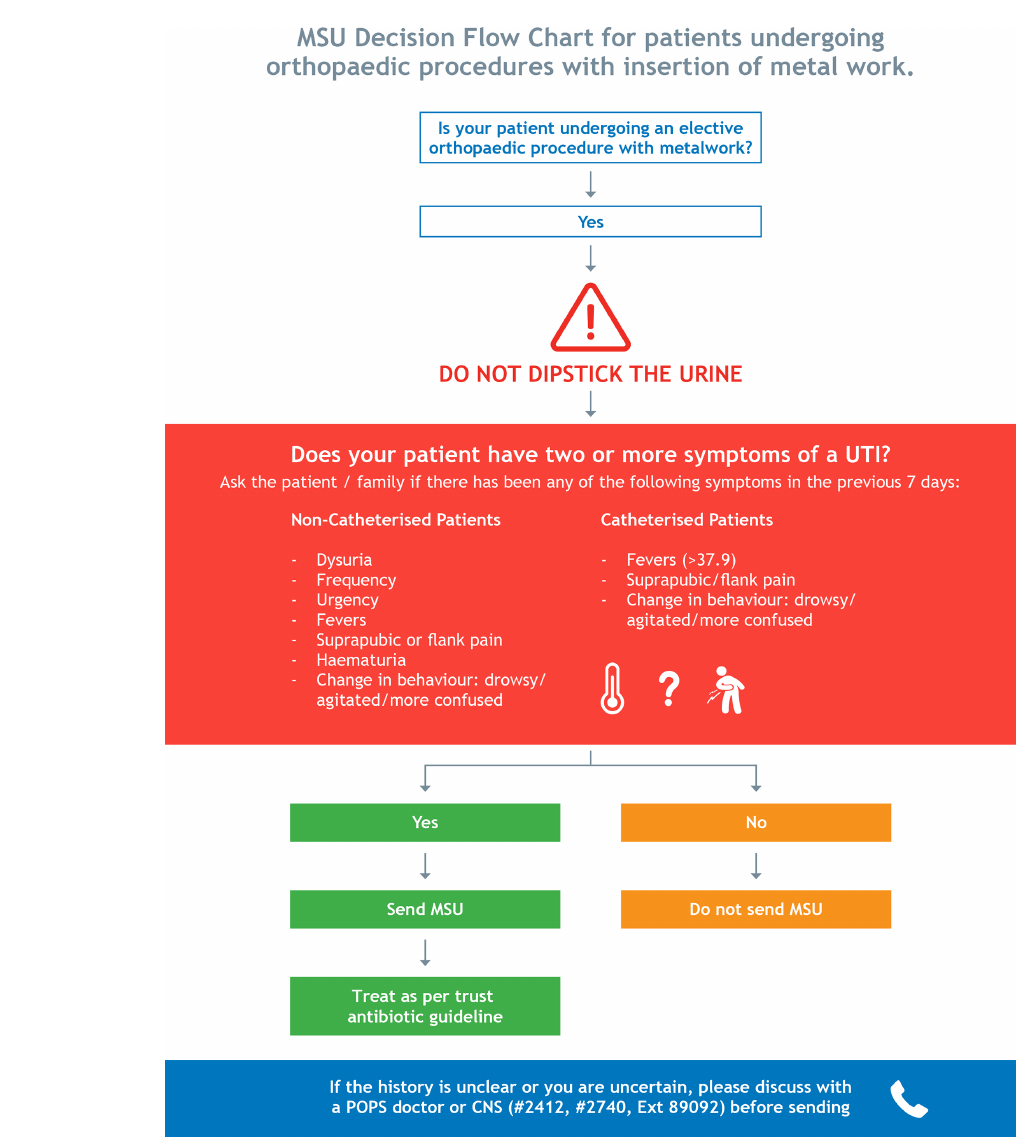
Figure 2. MSU decision flow chart guideline for preoperative MSU testing in elective orthopaedic surgery with insertion of